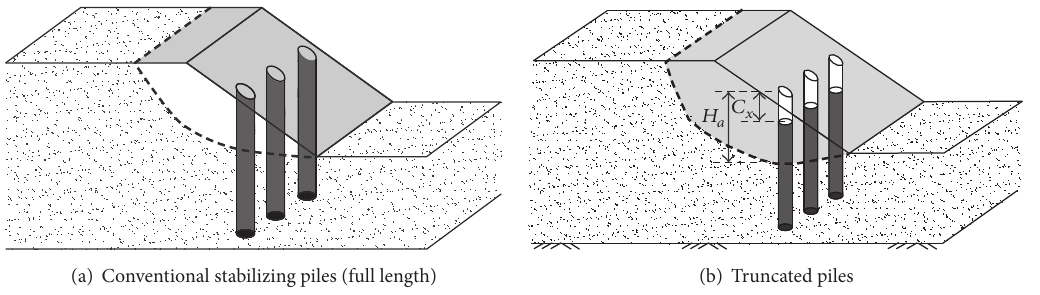
Figure 1: Comparison of conventional stabilizing piles and truncated